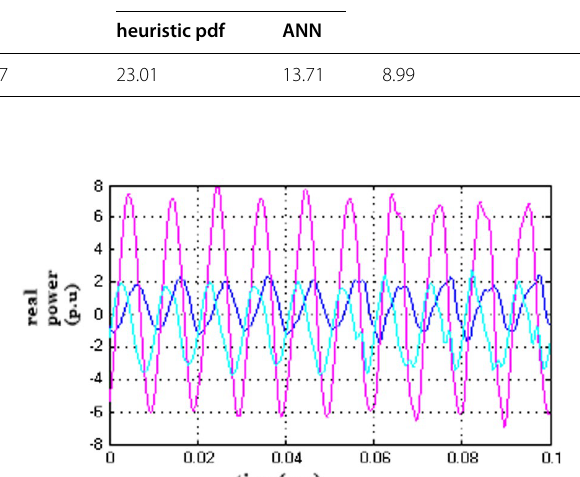
Fig. 23 Real power flow at bus 16 with ANFIS switching of STATCOM of IEEE 57- bus system